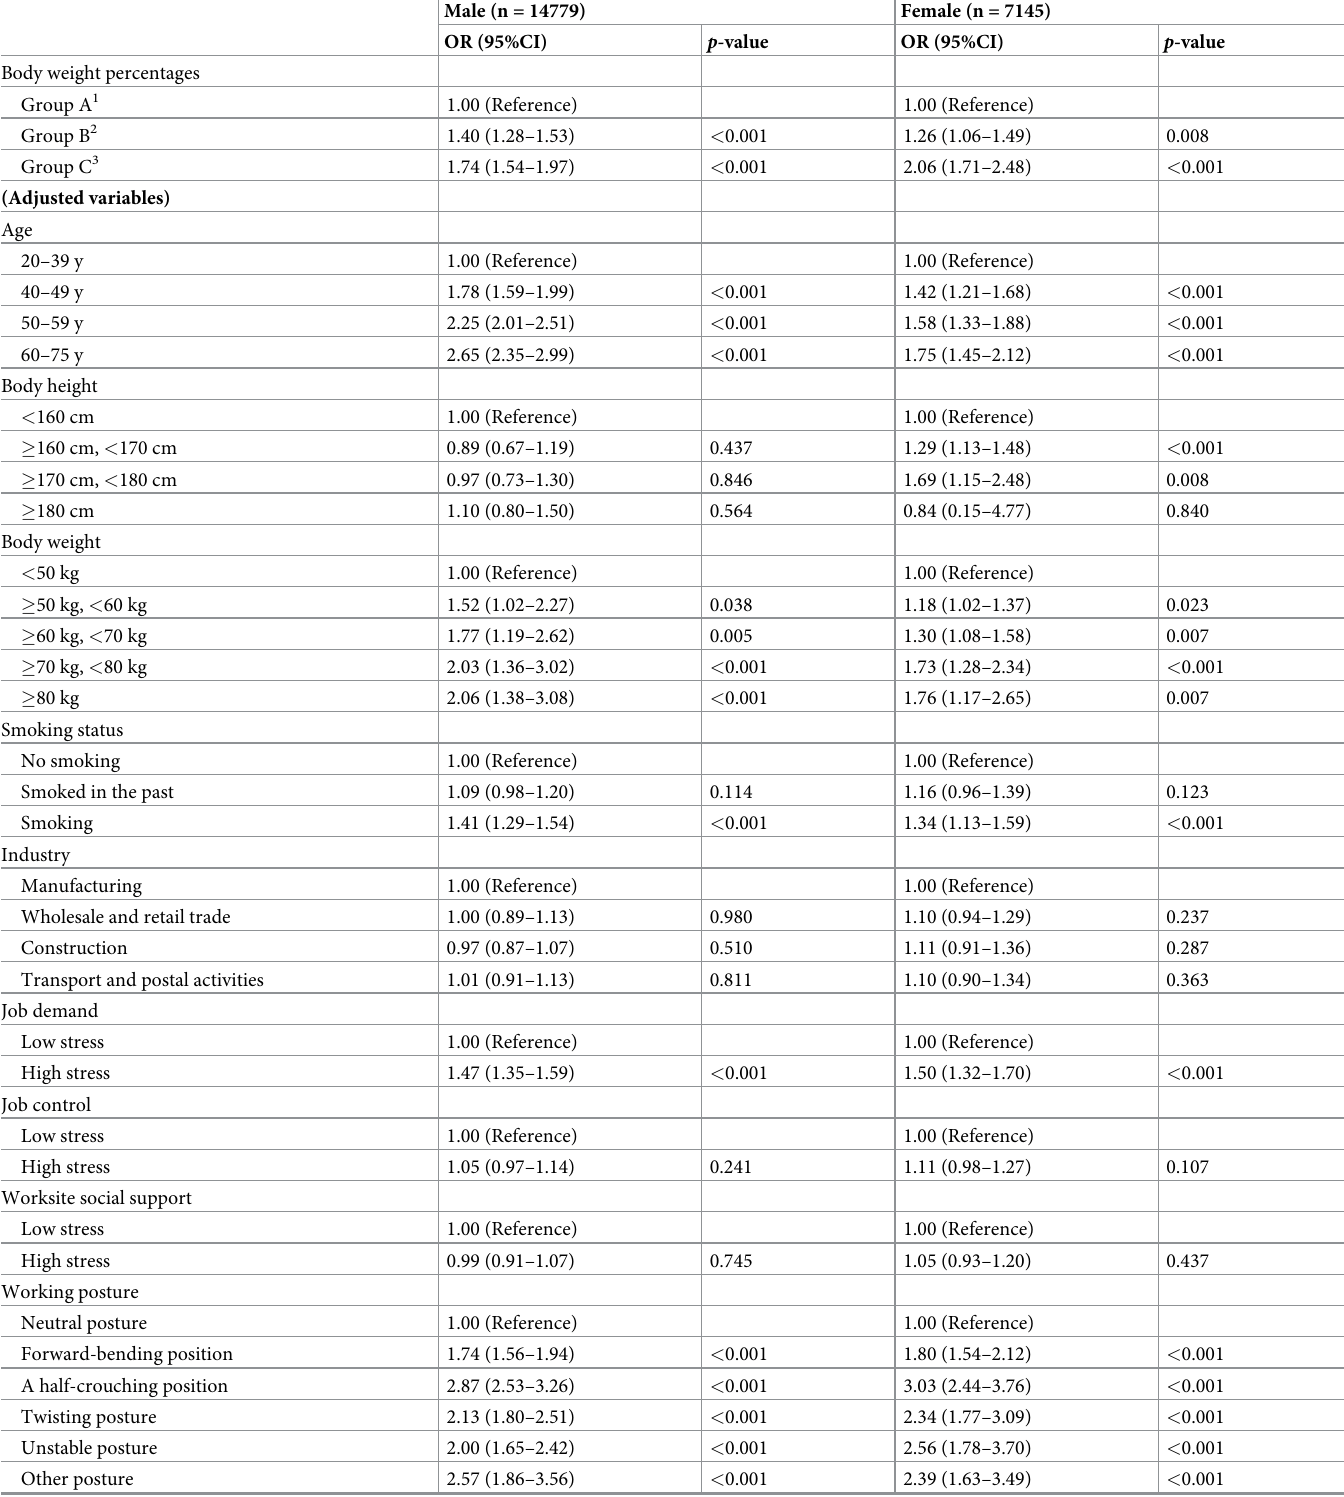
Table 3. Association of severe low back pain with weight limit as body weight percentages from multiple logistic